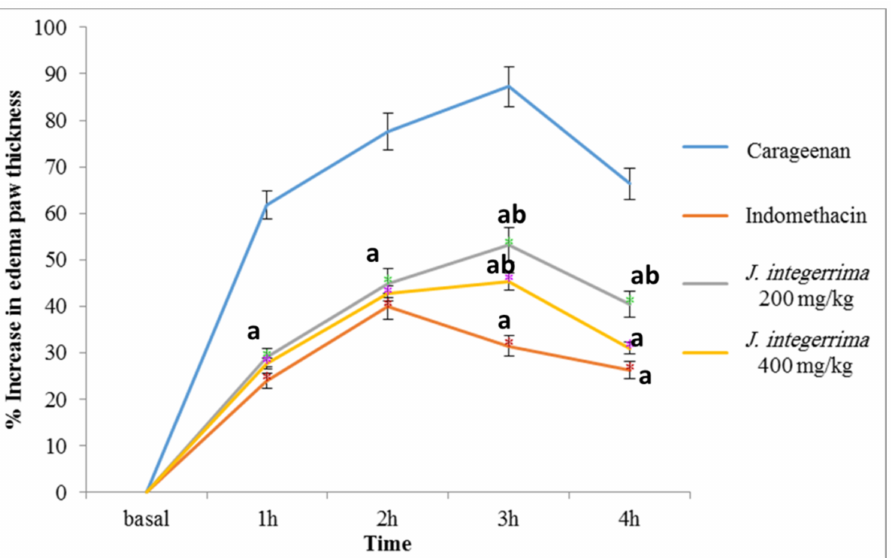
Figure 1. Effect of oral administration of ethanol extract of Jatropha integerrima leaves on edema volume. One way ANOVA and Fishers LSD comparison test were used, p < 0.05; a: significantly different from carrageenan control group at respective time point; b: significantly different from indomethacin group at respective time